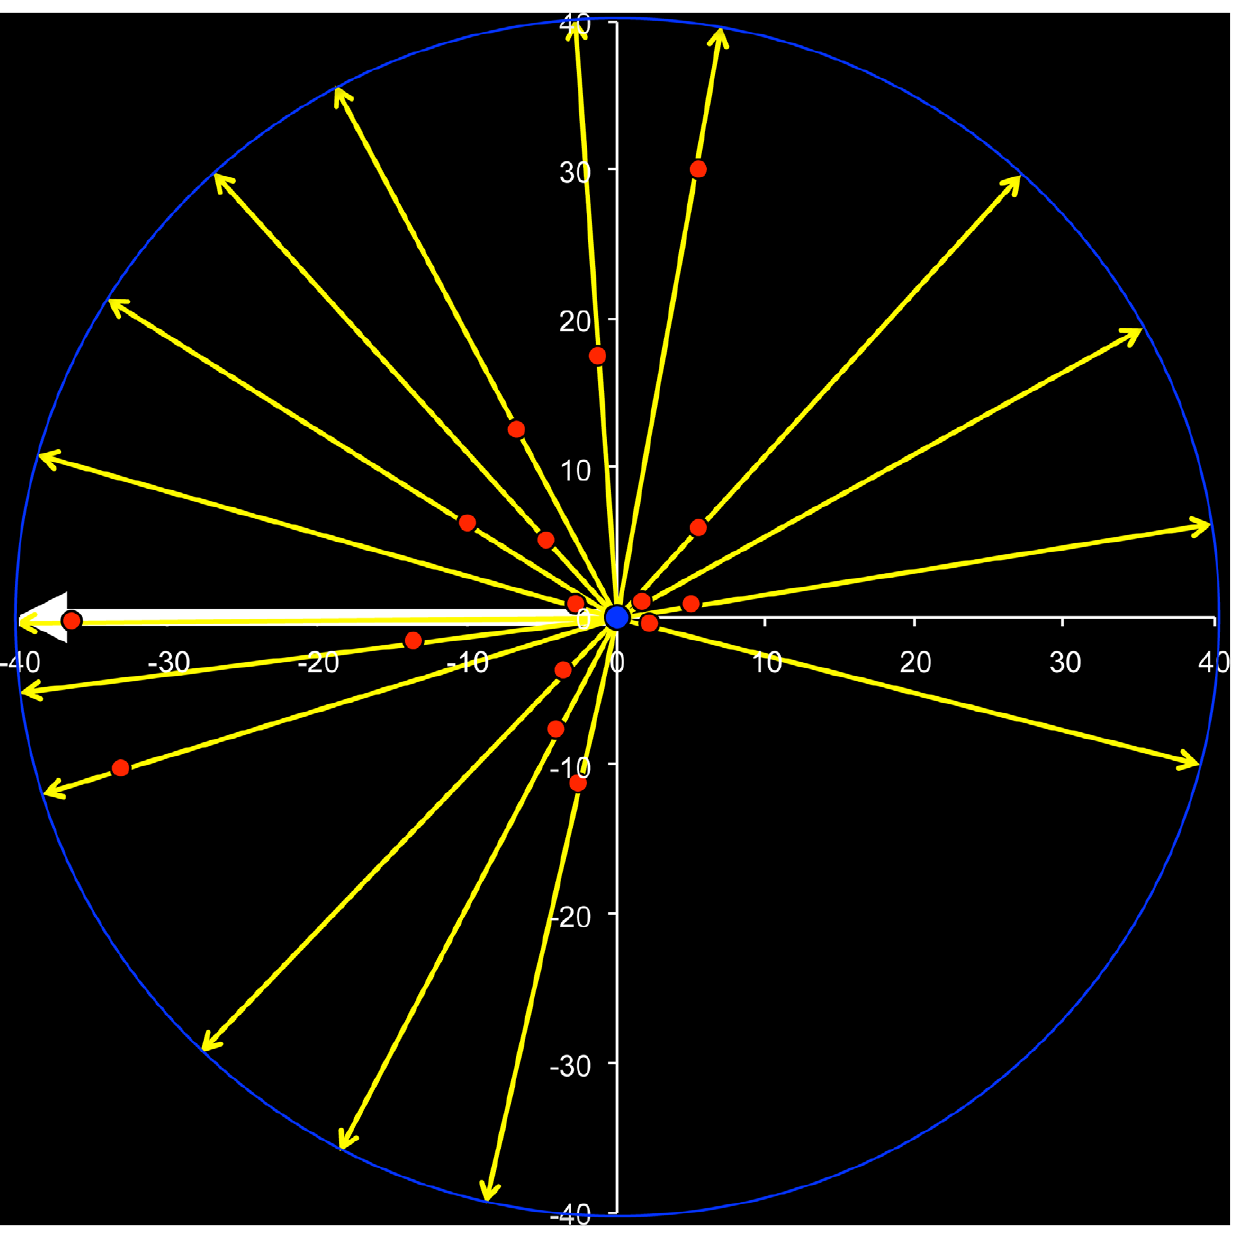
Figure 2. Post-release orientation (yellow arrows) of translocated elephants relative to capture site (white arrow). The blue circle denotes the release point for all elephants and red circles the spatial means of GPS locations over the first 10 days post-release for individual elephants. The binomial probability of the number of elephants orienting towards the capture location (left hemisphere) vs away (right hemisphere) was 0.69 (n=16, p=0.11, 95% CI 0.44;